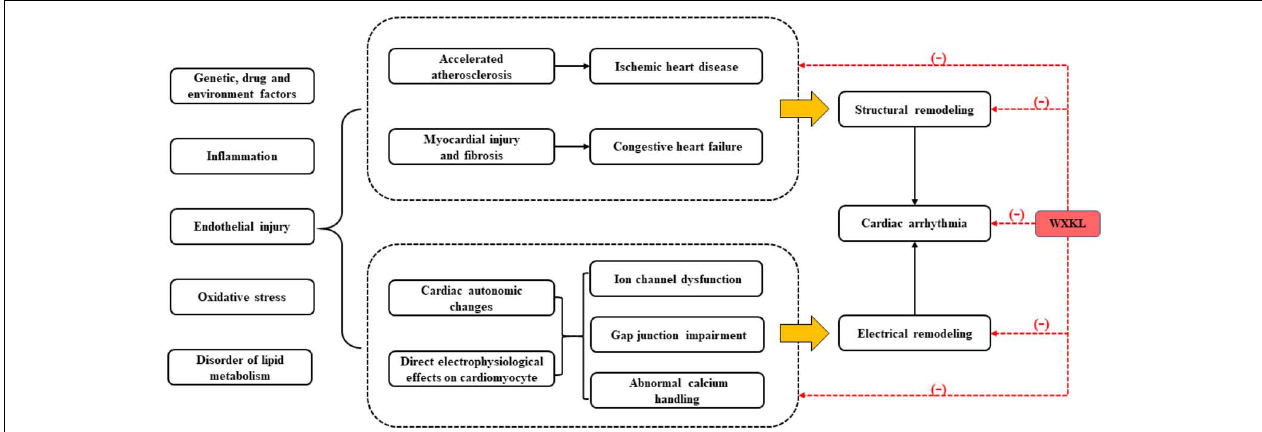
FIGURE 6 | The comprehensive effects of WXKL in